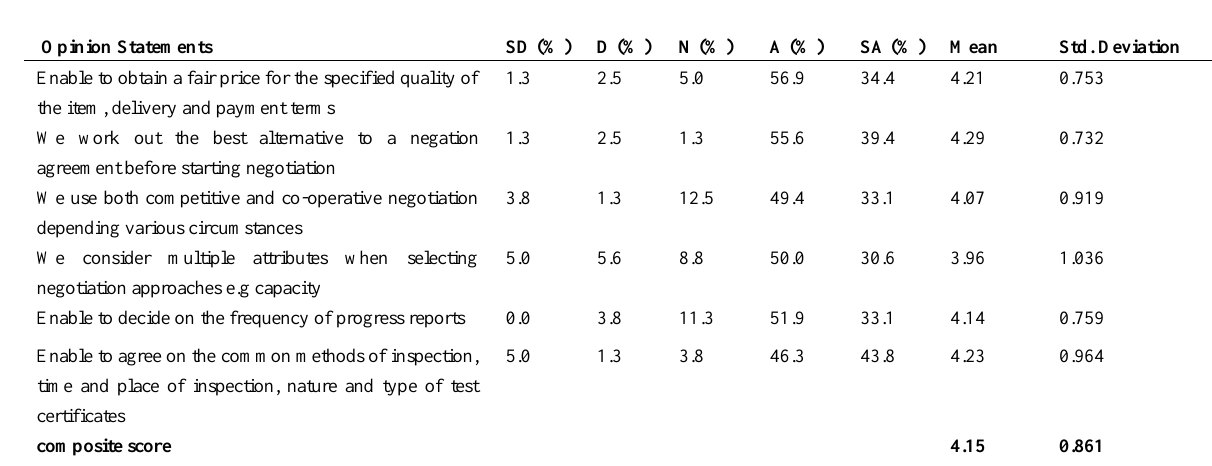
Table 1: Results of Strategic Negotiation